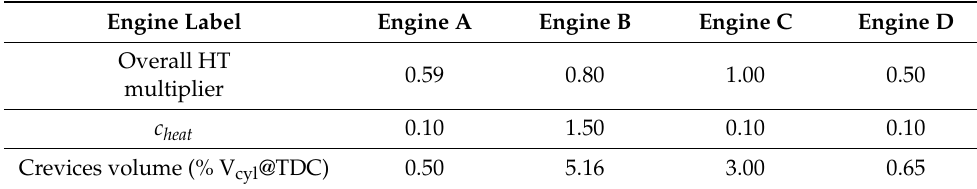
Table 5. Model tuning parameters and crevices size.